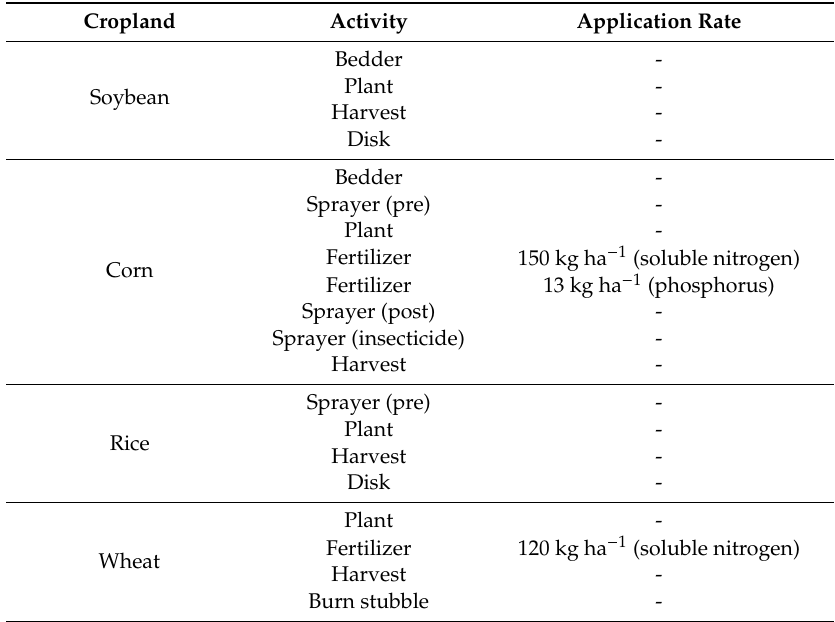
Table 2. Typical crop management operation for the crops planted in agricultural watersheds within the Mississippi Delta Region (MDR) used in this